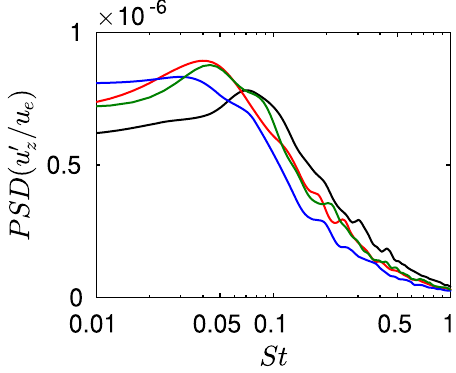
Figure 12. Power spectral densities of the fl uctuations of axial velocity u 0 z at r = r 0 and z = z max for L = 15 r 0 , L = 20 r 0 , L = 25 r L = 30 r 0 and 0 .